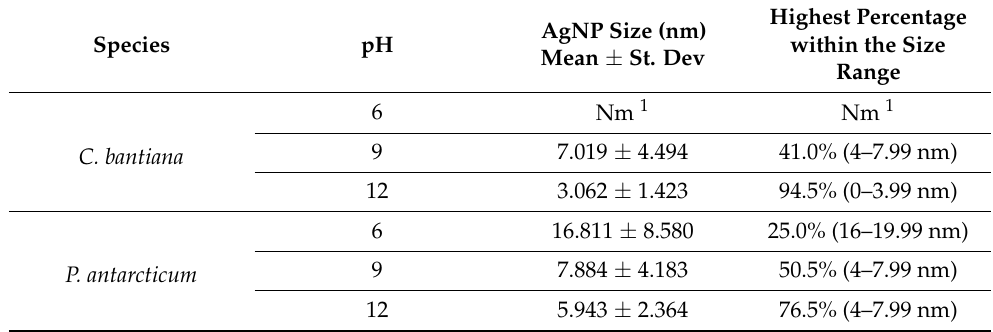
Table 3. Size statistical analysis of the AgNPs synthesised using FCF extract, 0.5 mM AgNO 3 , 1